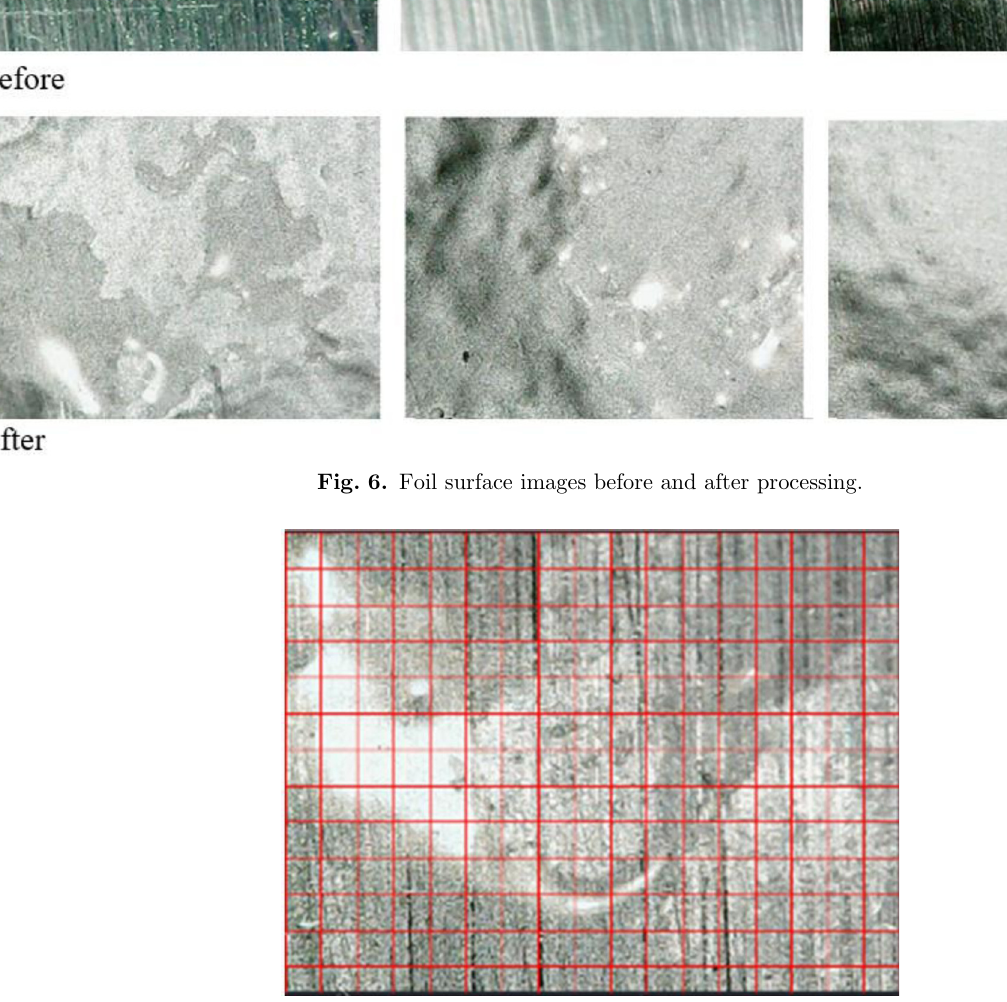
Fig. 7. Foil surface image with digital grid.